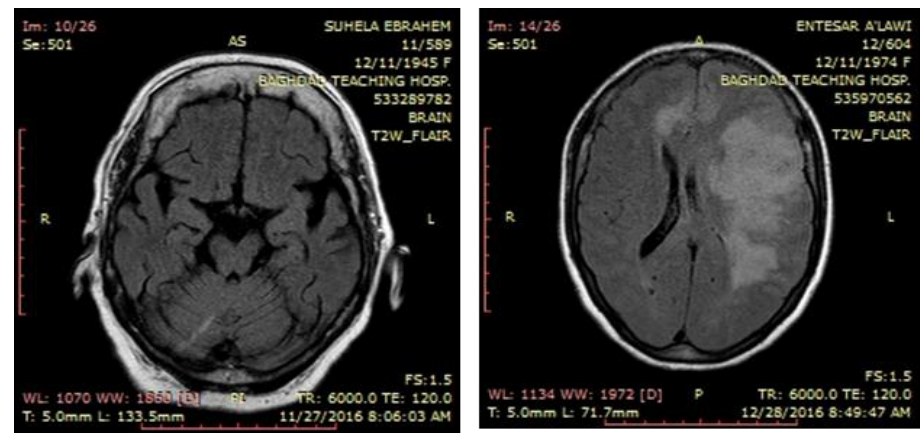
Fig. 1: The brain images of the MRI of two types of diseases from Baghdad medical